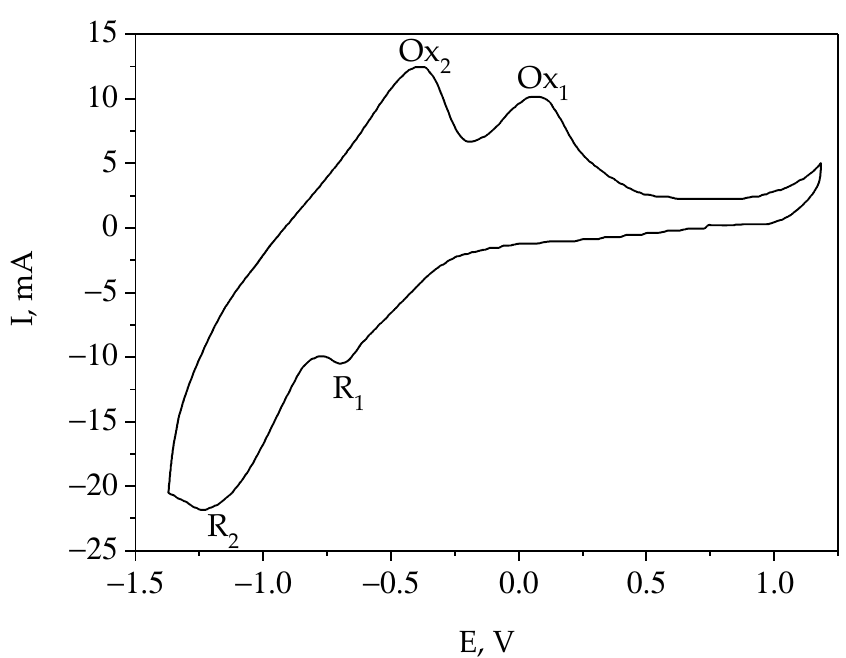
Figure 16. Cyclic voltammogram of the NaCl-KCl-NaF(10 wt.%)–K 2 SiF 6 melt. Concentration of K 2 SiF 6 is 6.87 × 10 –5 mol cm –3 ; v = 0.2 V s − 1 ; T = 1023 K; A = 0.162 cm 2 . The quasi-reference electrode was the SU-2000 glassy carbon.